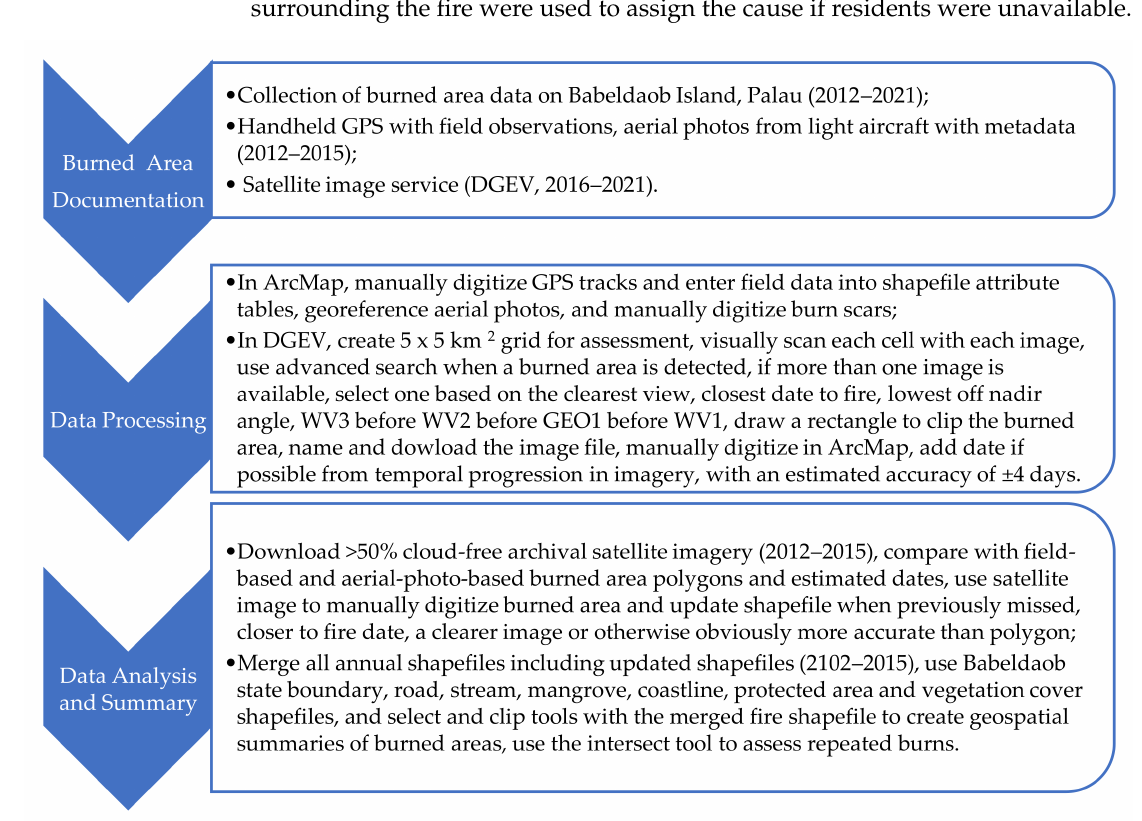
Figure 2. Flow chart of steps to document a wildfire history on a small